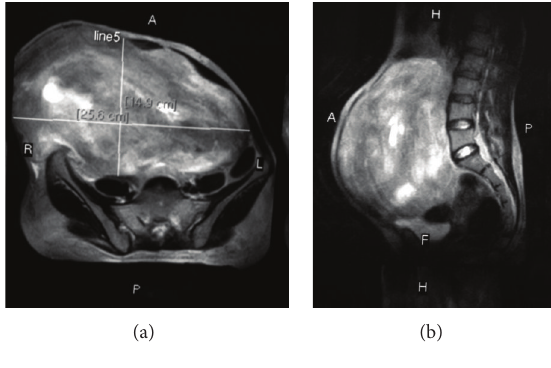
Figure 3: MRI images.